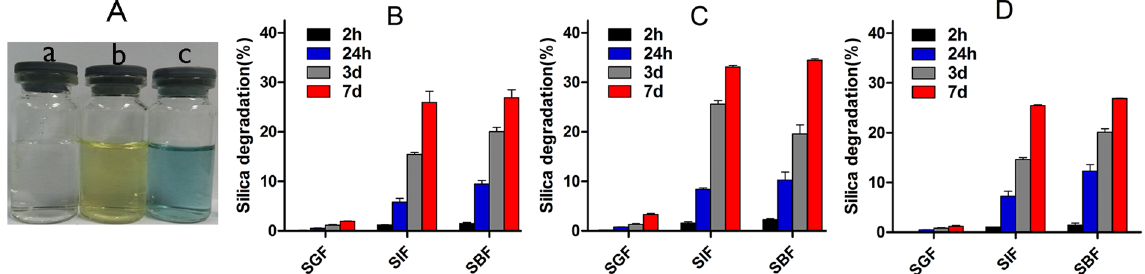
Figure 7. ( A ) The verification of degradation products. And Quantitative analysis of the degradation products of NLR ( B ), NSR ( C ), NS ( D ) in SGF, SIF and SBF at different points by